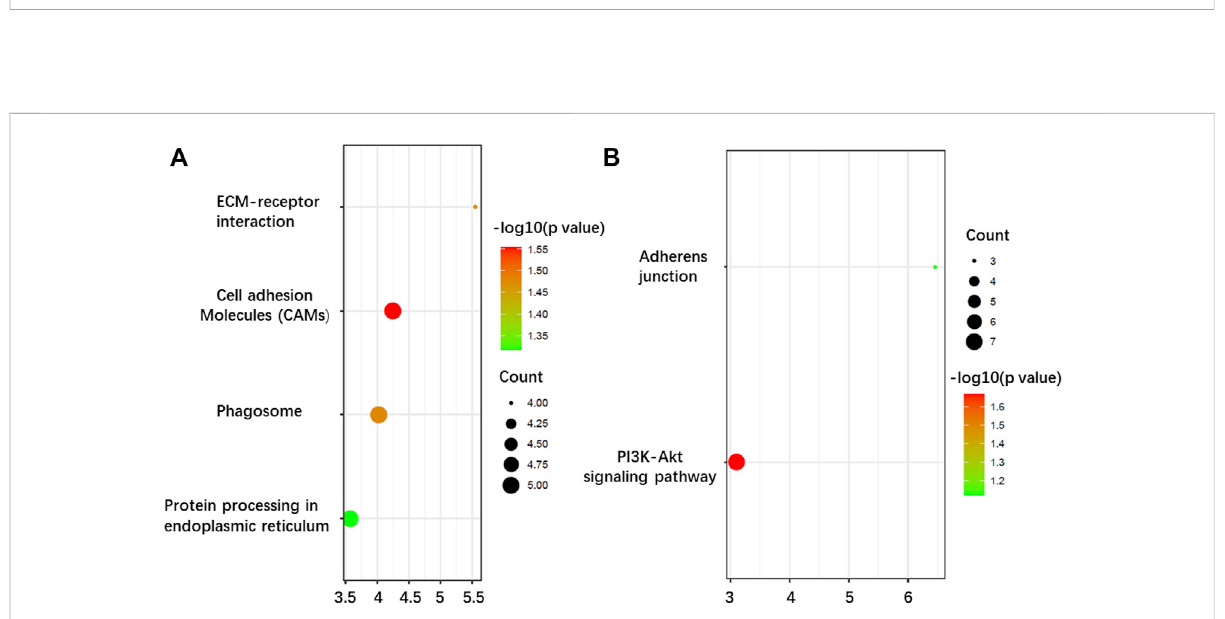
FIGURE 6 Kyoto Encyclopedia of Genes and Genomes (KEEG) pathway enrichment analysis of the N-glycoproteins corresponding to the DEPGs in SKOV3 relative to IOSE80 cells. (A) Enrichment of 421 upregulated genes. (B) Enrichment of 325 downregulated genes.